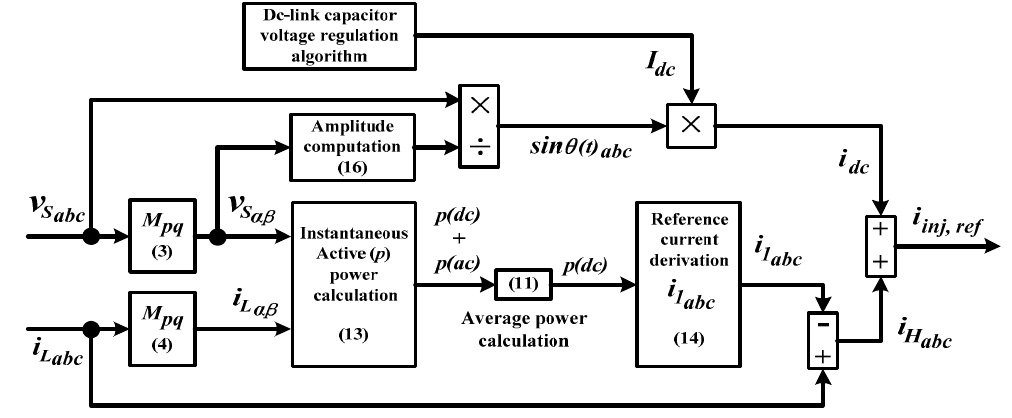
Figure 3. Control structure of reference current generation algorithm based on the proposed dual-function pq theory.